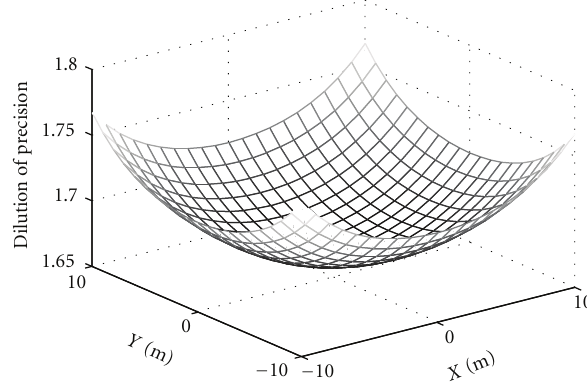
Figure 3: The geometric dilution of precision (GDOP) versus the position of the antenna element in the